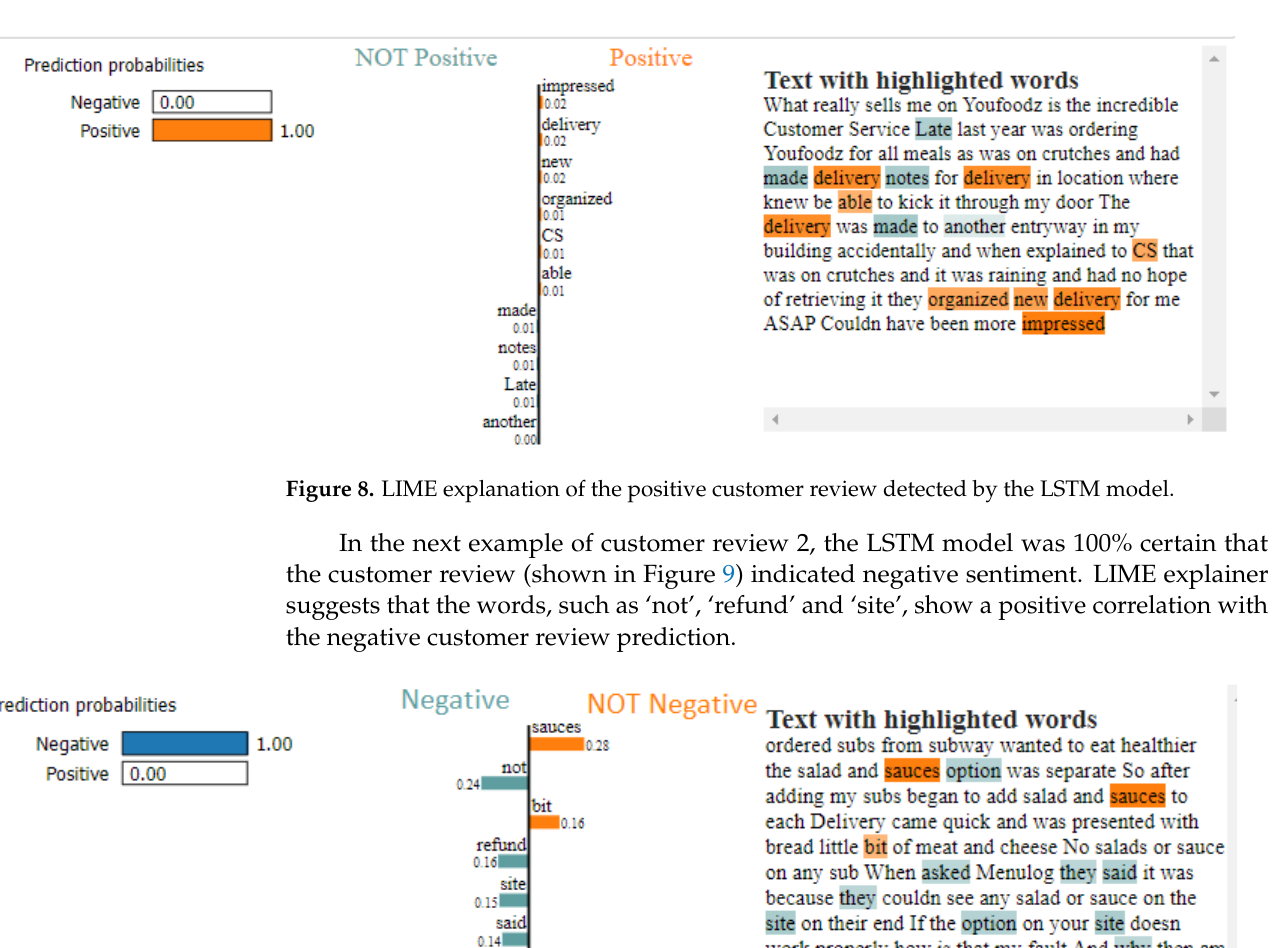
Figure 7. SHAP explanation of the negative customer review detected by the LSTM model.